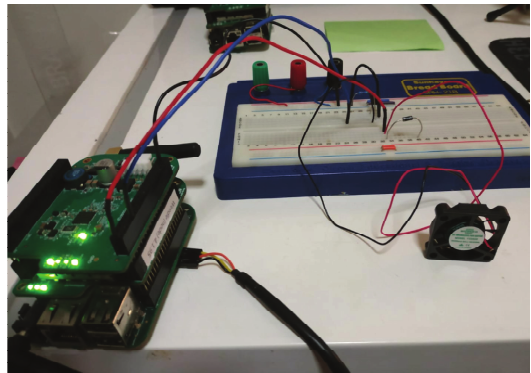
Figure 2. Implementation using Itron Riva